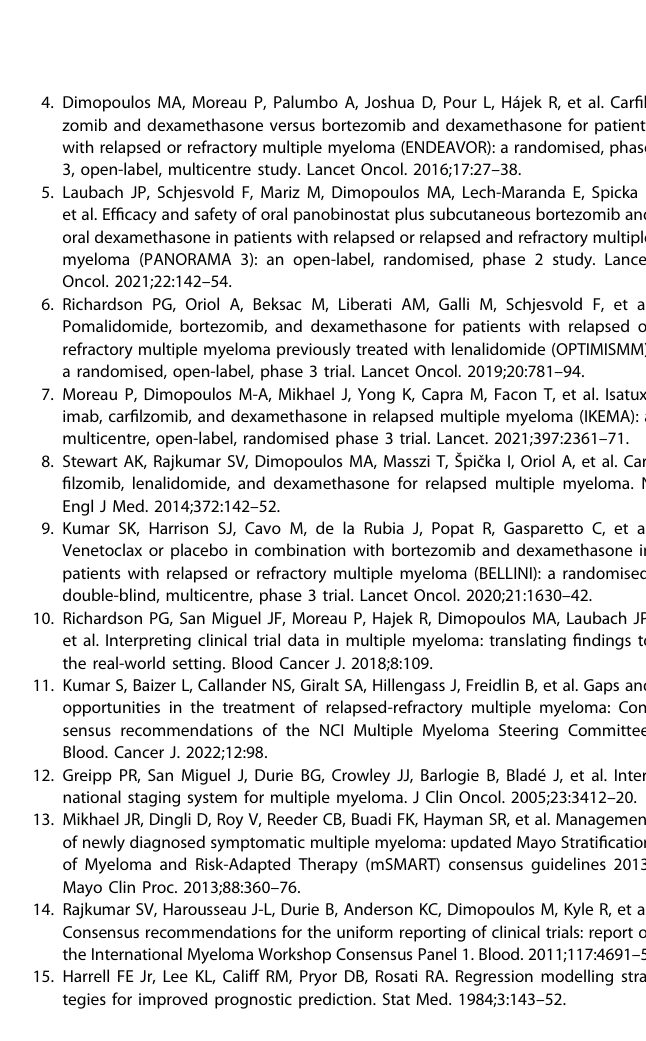
Overall survival Number of lines Median OS (months) Number of drugs/drug